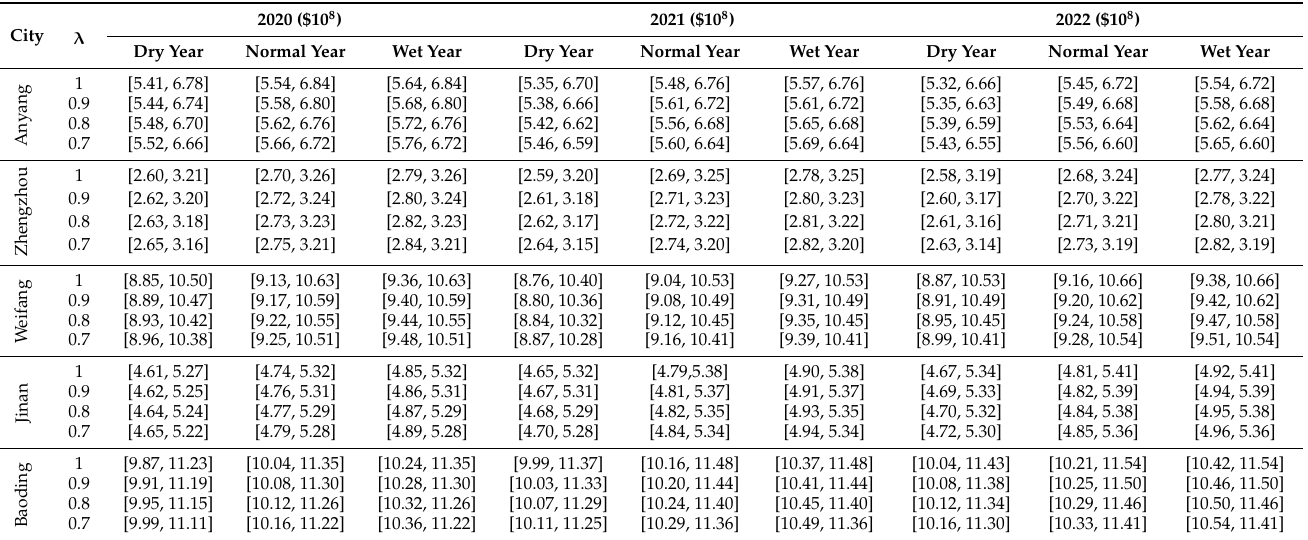
Table 12. Interval parameters of production value of summer corn in five cities under different possibilities and